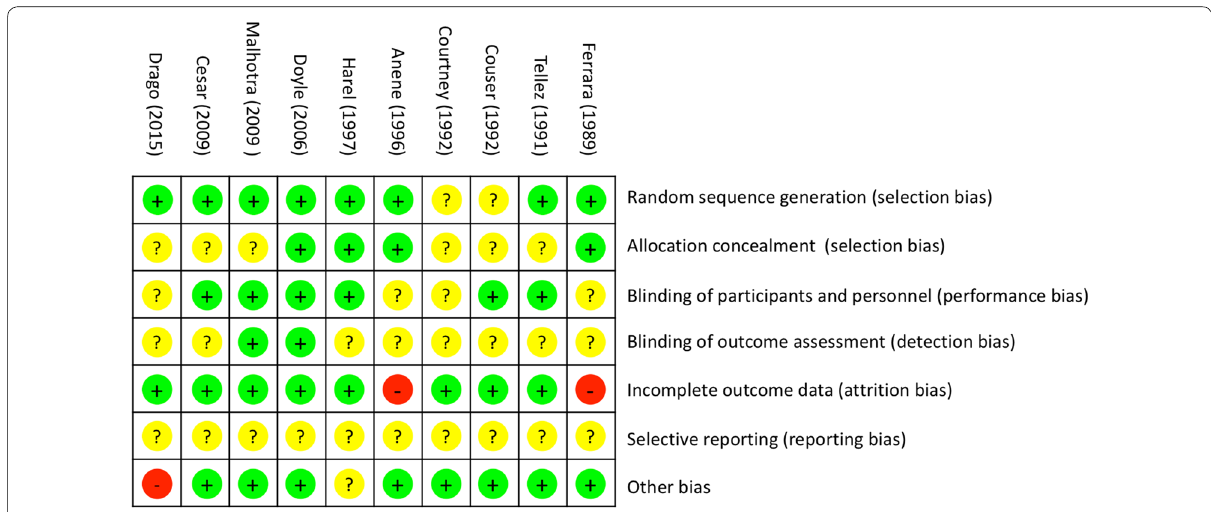
Fig. 2 Risk of bias summary of randomized controlled